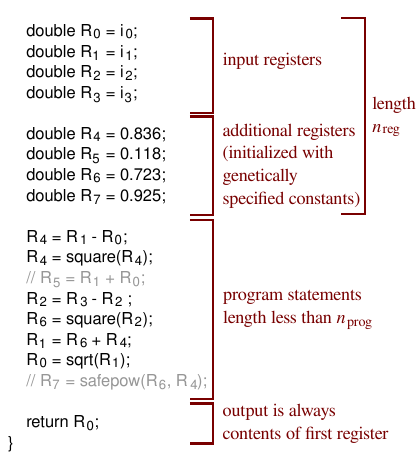
Fig. 1. An example LGP program, instantiating the 2D Euclidean distance function, written in pseudo-Java notation. Note the existence of ineffective (“neutral”) code, commented out in light